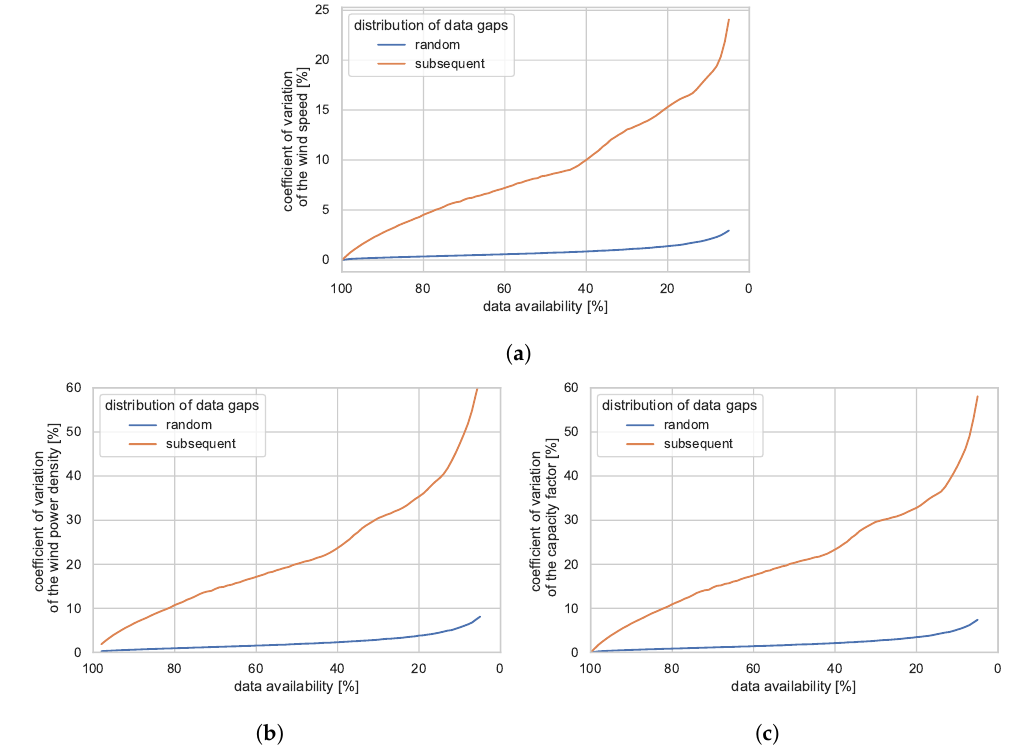
Figure 4. Coefficients of variation for different KPIs caused by a reduction in data availability. Randomly distributed data gaps are compared to continuous data gaps. ( a ) wind speed, ( b ) wind power density, ( c ) capacity